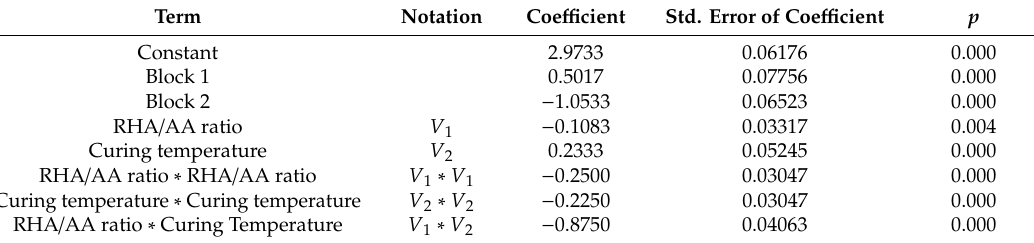
Table 6. Estimated e ff ects and coe ffi cient for adhesion